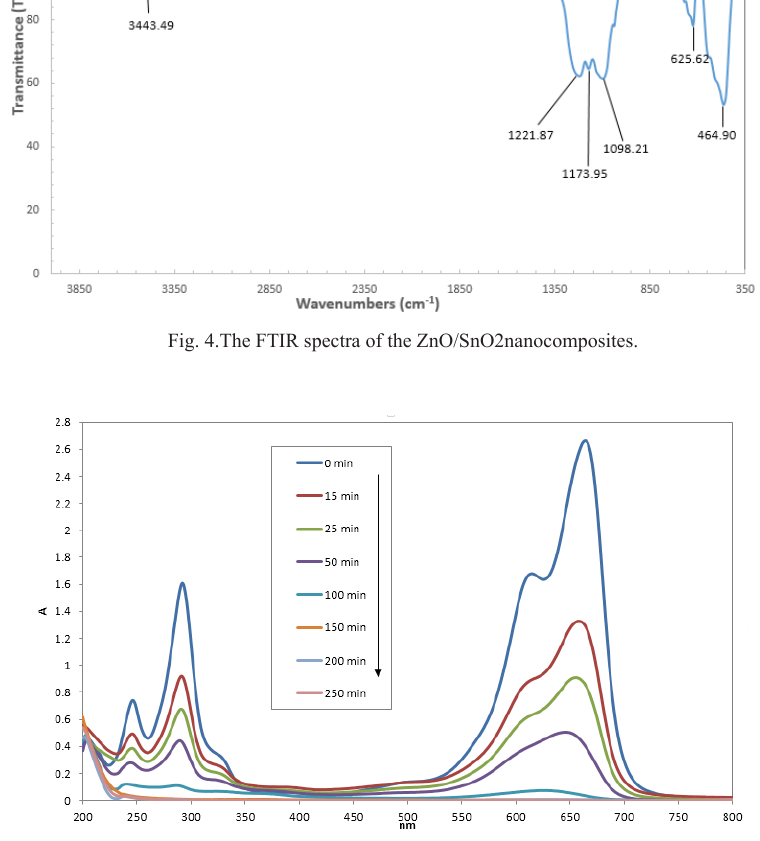
Fig. 5. The absorbance spectra changes of the 20 mg/L MB solution in the presence of 0.5 g ZnO/SnO 2 and irradiation.